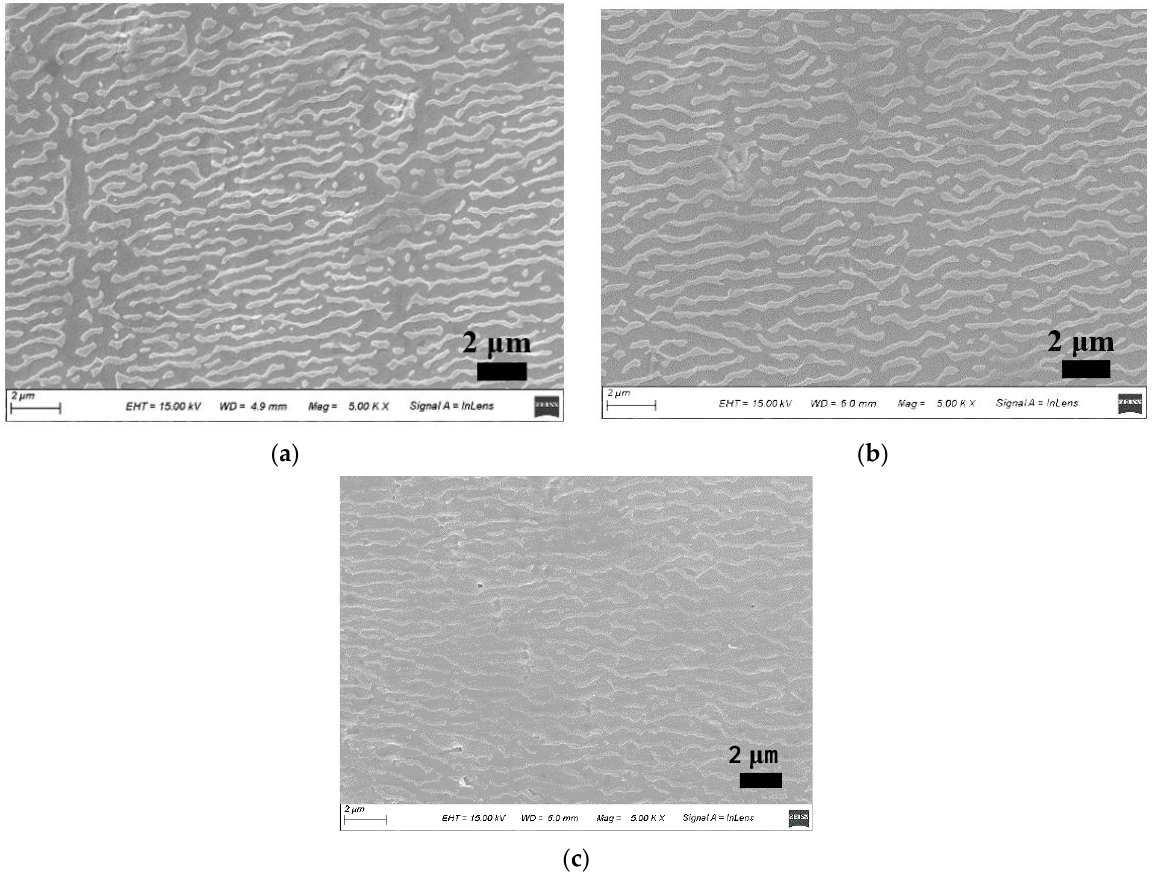
Figure 5. Creep fracture microstructure of specimens with different diameters ( a ) 2.5 mm, ( b ) 3 mm and ( c ) 5 mm.